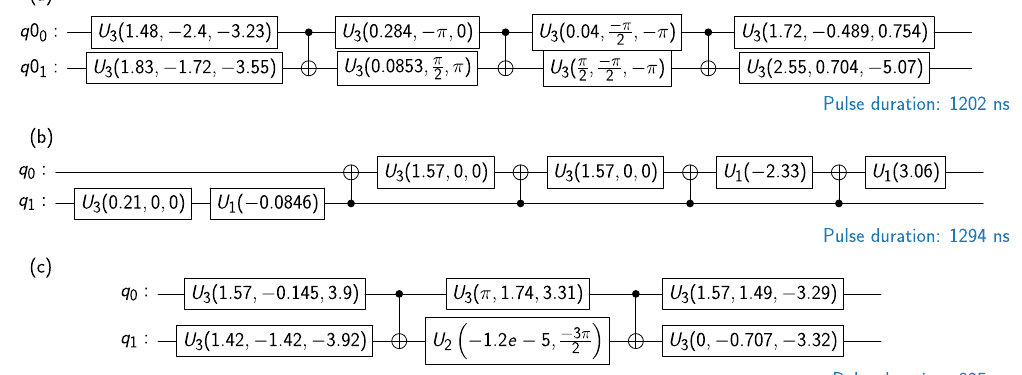
Fig. 7 Circuits from decompiled control pulses. Illustration of circuits constructed using the unitary and state vectors from ctrl-VQE. a Circuit corresponding to unitary obtained from a KAK decomposition. b An arbitary circuit corresponding to the state vector. c Transpiled version of circuit ( b